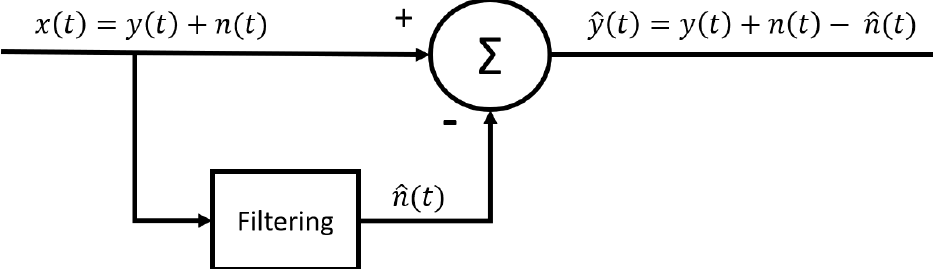
Figure 4. General block diagram of an interference reduction method using an adaptive estimation of the interference signal by means of filtering the raw